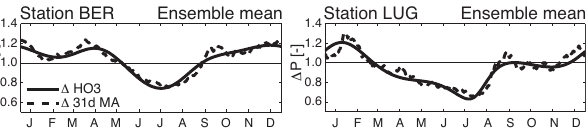
Fig. 6. Examples of the ensemble mean ∆ P as estimated by a 31d MA (dashed lines) and the HO3 spectral smoothing (solid lines) at the station sites BER and LUG. Examples are shown for the SCE period 2070–2099.